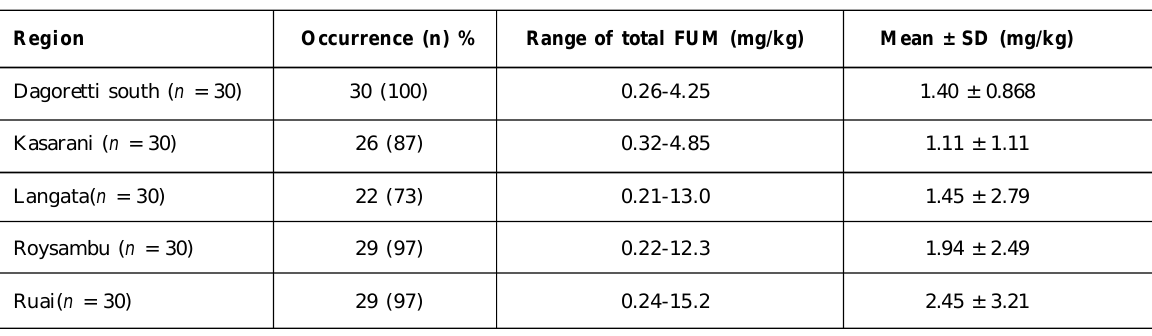
Table 6: Fumonisin levels of layer feeds grouped by regions in Nairobi County, Kenya Region Occurrence (n) % Range of total FUM (mg/kg) Mean ± SD